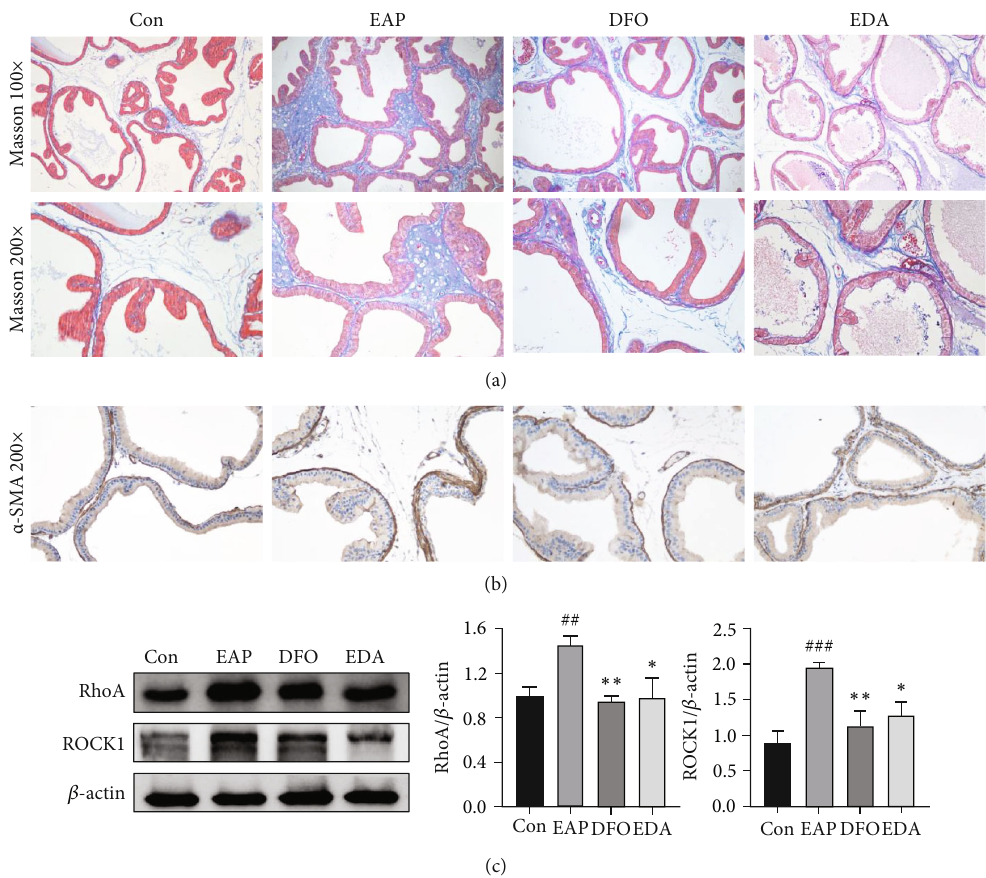
Figure 6: DFO and EDA prevented stromal fi brosis in the EAP model. (a) Representative Masson ’ s trichrome-stained images of prostate tissue. (b) Immunohistochemical staining of α -SMA. (c) Western blot analysis of RhoA/ROCK1 signaling, and the relative quantitative results are shown. Data was presented as mean ± SEM . ## P < 0 : 01 versus the control group; ### P < 0 : 001 versus the control group; ∗ P < 0 : 05 versus the EAP group; ∗∗ P < 0 : 01 versus the EAP